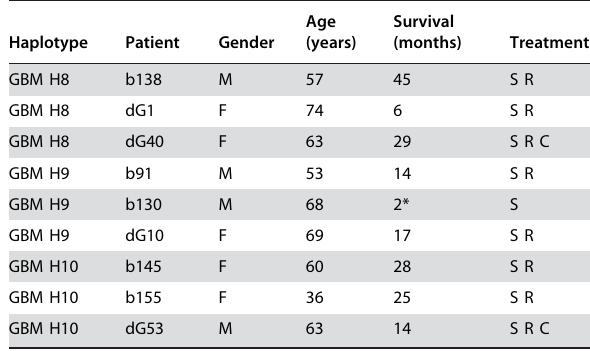
Table 2. Demographic and clinical data of GBM patients